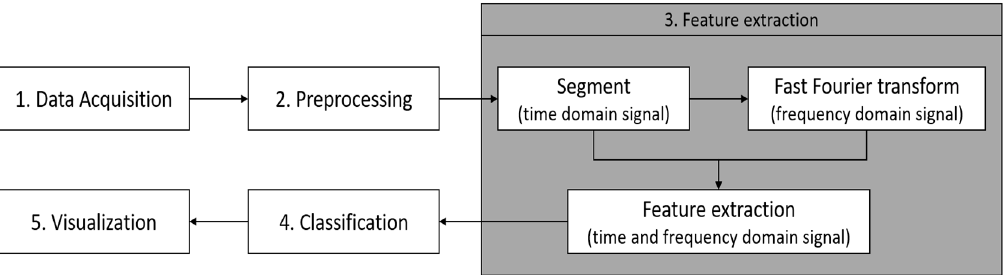
Figure 3. An architecture for statistical feature extraction.